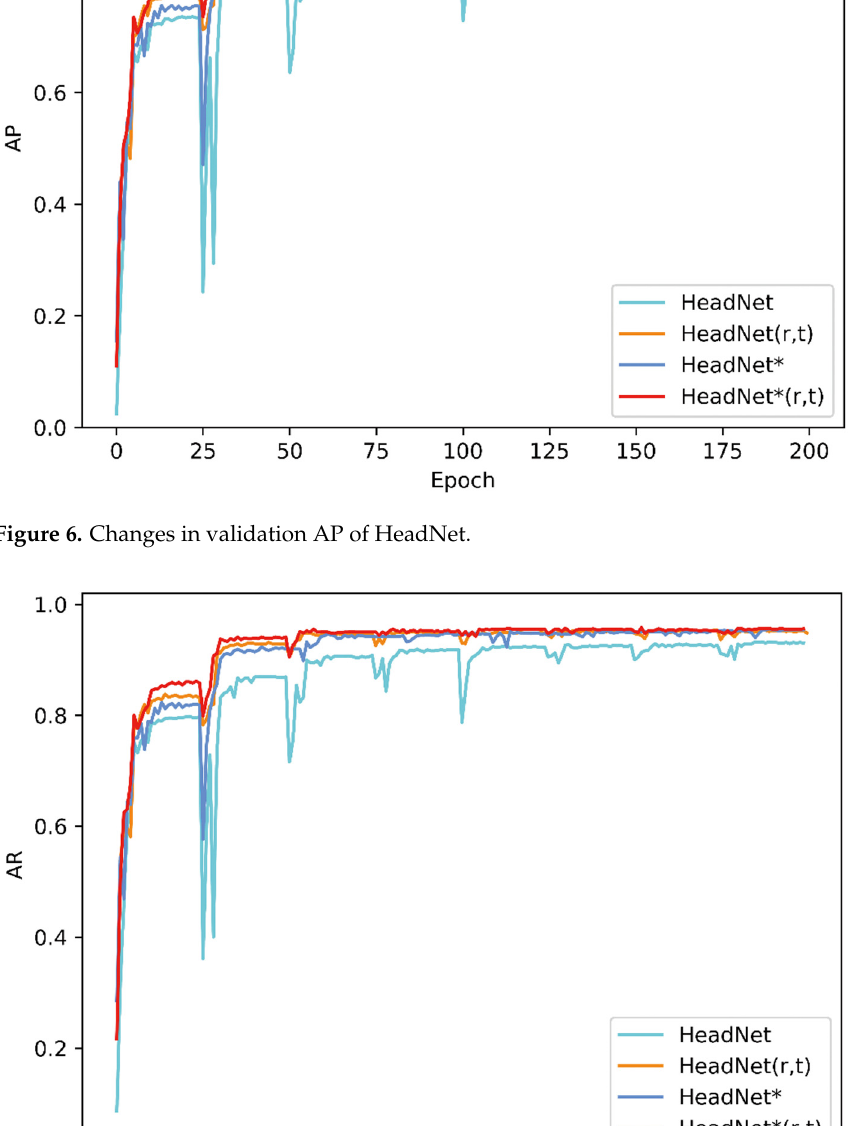
Table 2. Performance of HeadNet on test dataset.